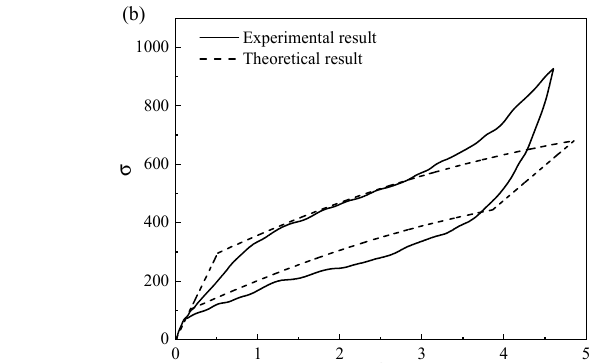
Figure 5. Comparisons of the theoretical and experimental results of ( a ) solid SMA and ( b ) porous SMA with a porosity of 13%.